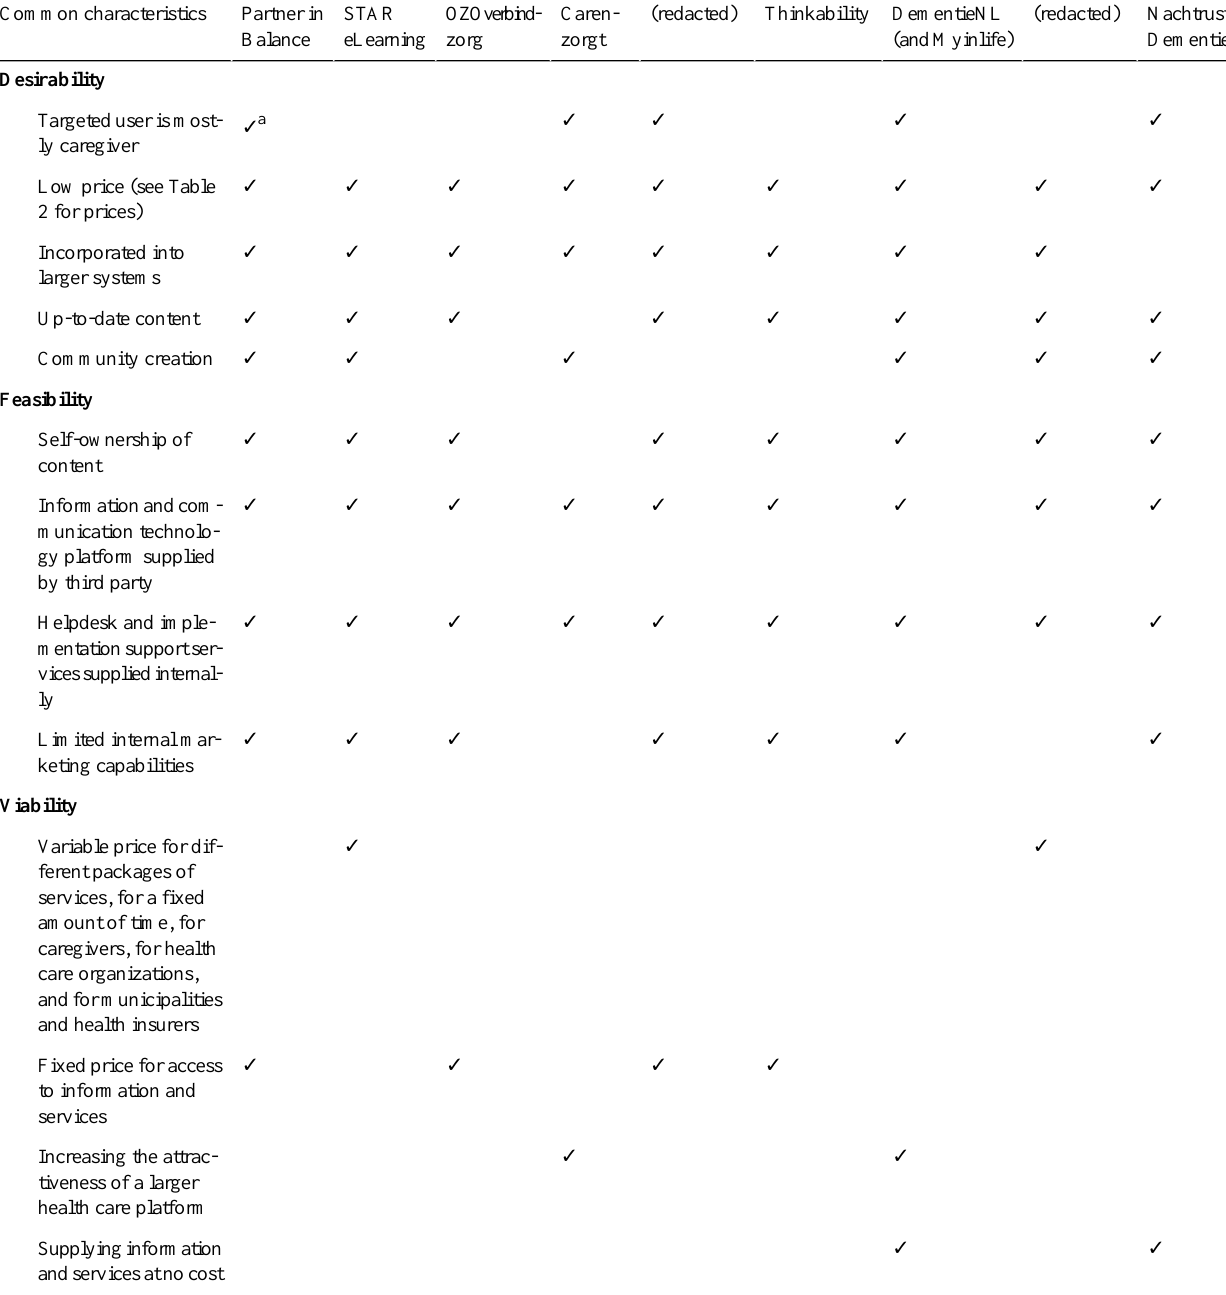
Table 3. Common case study characteristics, as reported in case study